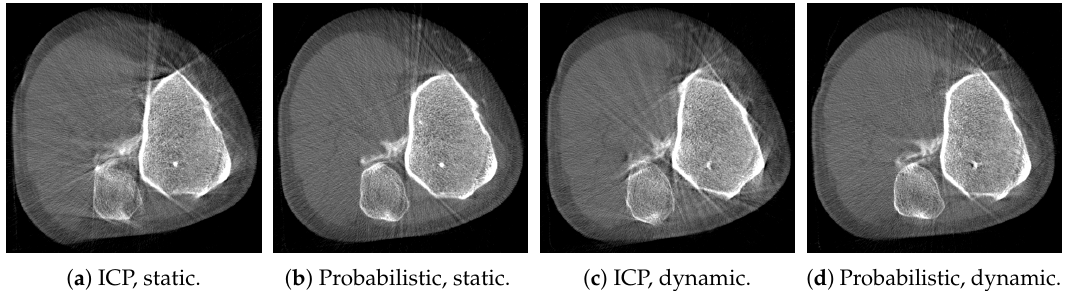
Figure 5. Reconstruction results of dataset 1 achieved with noisy point